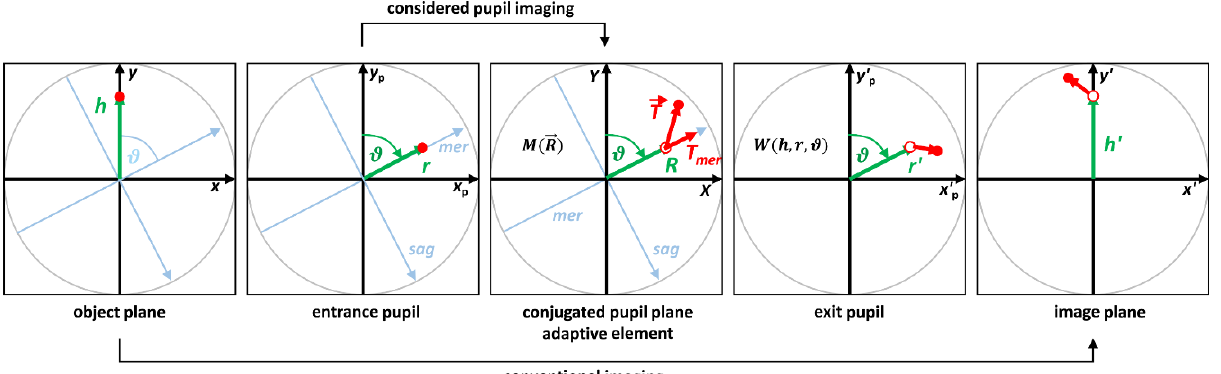
Fig. 1. Coordinate systems for object, pupil and image planes of a rotationally-symmetric optical system. Positions, where a selected ray hits the planes, are marked with a red dot, respectively. A solid dot gives the actual position, while a blank dot indicates the ideal position with no aberrations present. The vector between these dots yields the transverse ray aberration in that plane. The green vector indicates the coordinates of the ideal ray location in polar coordinates in each plane. For object imaging, the line connecting the optical axis with the object point determines the meridional direction by definition, which is the y-direction here. For pupil imaging, however, object and pupil planes exchange their role [1]. Therefore, the meridional direction for the Seidel series of pupil aberrations is determined in the entrance pupil plane by the line between the optical axis and the intersection of the ray in that plane. This direction together with the corresponding sagittal direction is indicated by the light-gray coordinate